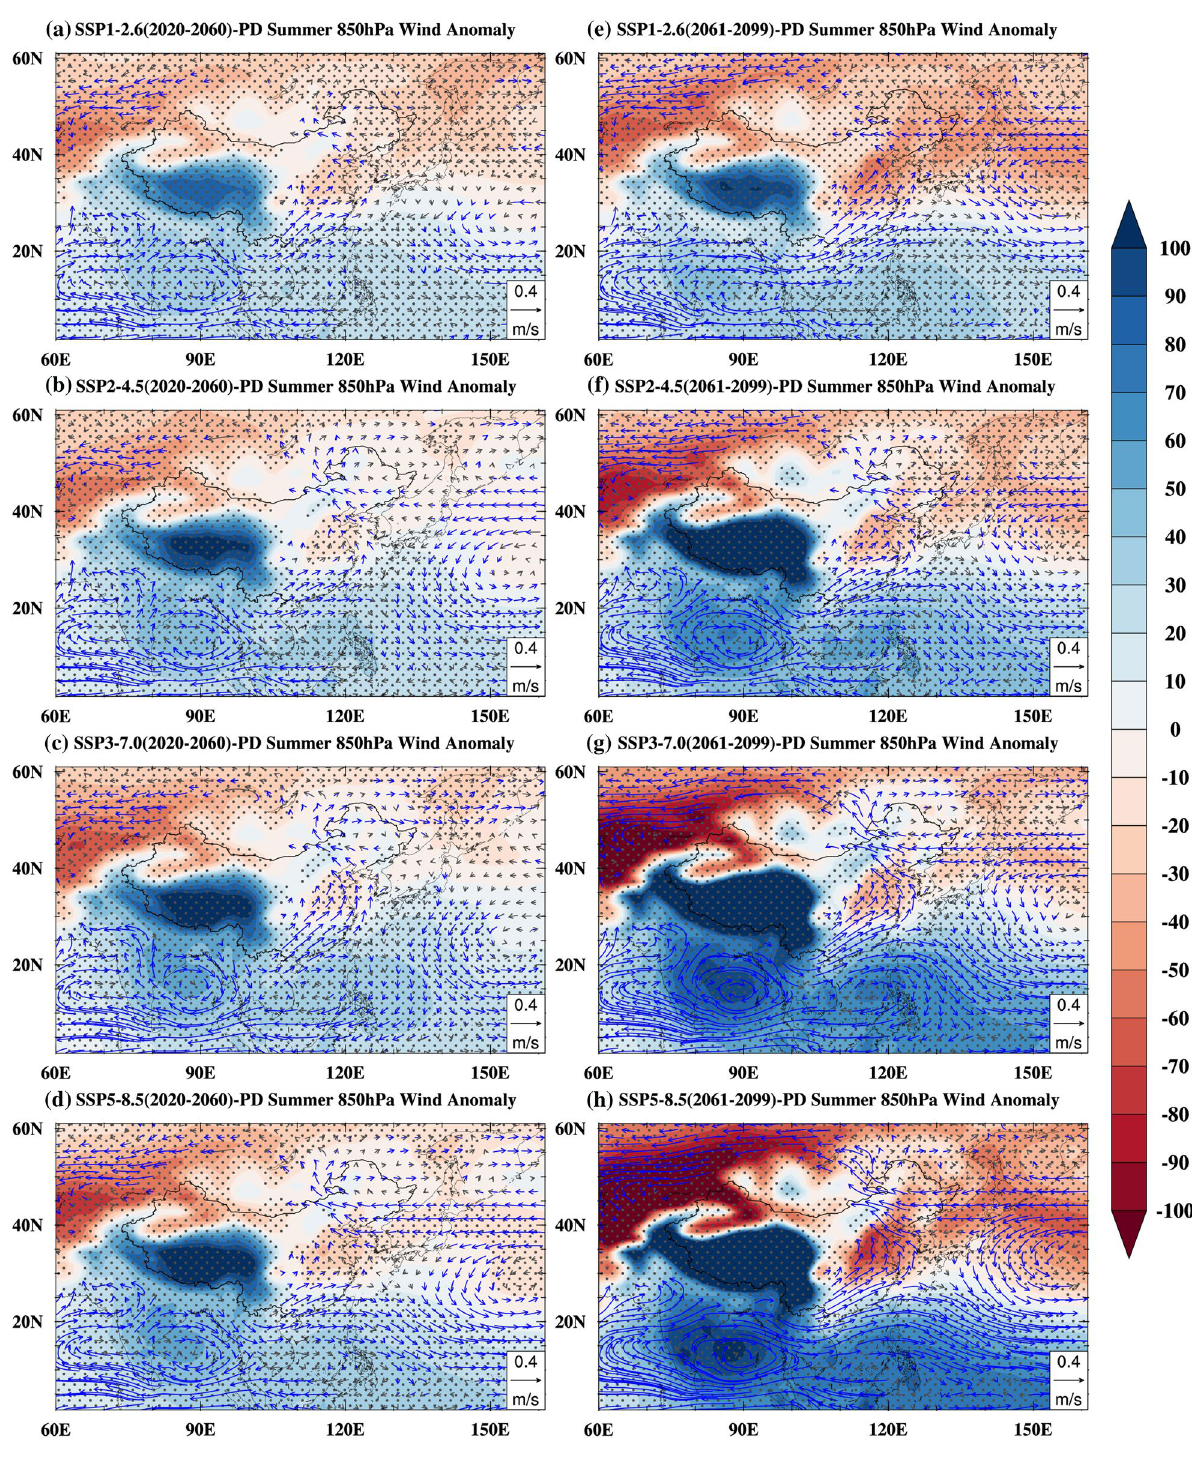
Figure 6. Summer sea level pressure and 850 hPa wind anomalies (unit: Pa, shading; unit: m/s, vectors) for 2020–2060 (near-term, a – d ) and 2061–2099 (late-term, e – h ) under the SSP1-2.6 ( a , e ), SSP2-4.5 (b, f), SSP3-7.0 ( c , g ), SSP5-8.5 ( d , h ) relative to the present day. The blue vectors and grey dots indicate a 5% of significance level. Maps were generated using the NCAR Command Language (The NCAR Command Language (Version